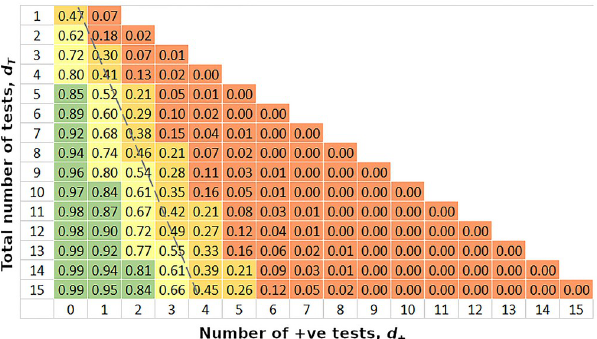
Fig 3. Probability of greater efficiency using pooling, as a function of the number of exploratory tests and the number of positive results. The exploratory diagnostic test is assumed to be perfect in this case. Prior knowledge of prevalence is uninformative. Pool size = 5. Green = > 80%, yellow = 80% - > 50%, orange = 50% - > 20%, red < = 20%. The broken grey line approximately tracks the critical prevalence for 100% relative cost for pool size of 5 and exploratory sample size of